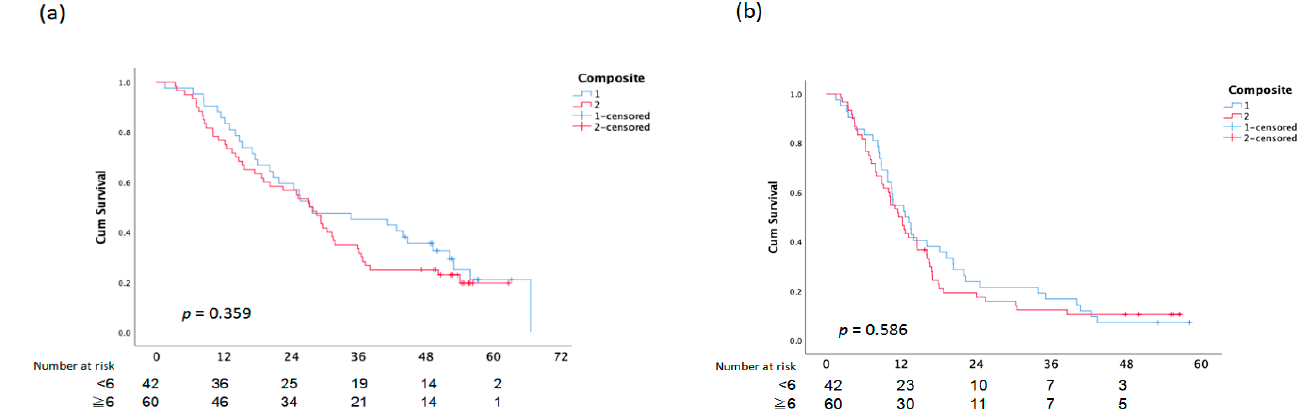
Figure 3. Overall Survival ( a ) and PFS ( b ) analysis according to Composite Score. Table 5. Association of clinical variables and skin reactions with median Progression Free Survival by univariate analysis (N = 111).